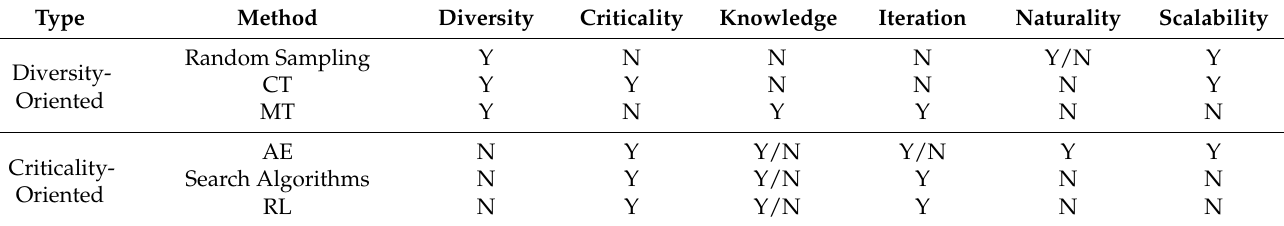
Table 3. Qualitative comparison of scenario generation strategies. “Diversity”: Capable of generating diverse scenarios that can fill the whole ODD. “Criticality”: Capable of finding a large percentage of critical scenarios. “Knowledge”: a certain amount of expert knowledge is needed. “Iteration”: Some iterations are required. “Naturality”: testing results can be mapped to that in natural traffic. “Scalability”: Capable of generating high-dimensional critical scenarios without consuming many resources. “Y”: Yes. “N”: No. “Y/N”: Yes, for some cases, and NO, for others. For example, random sampling can generate natural traffic scenarios if sampling on the parameter distributions in natural traffic, and vice